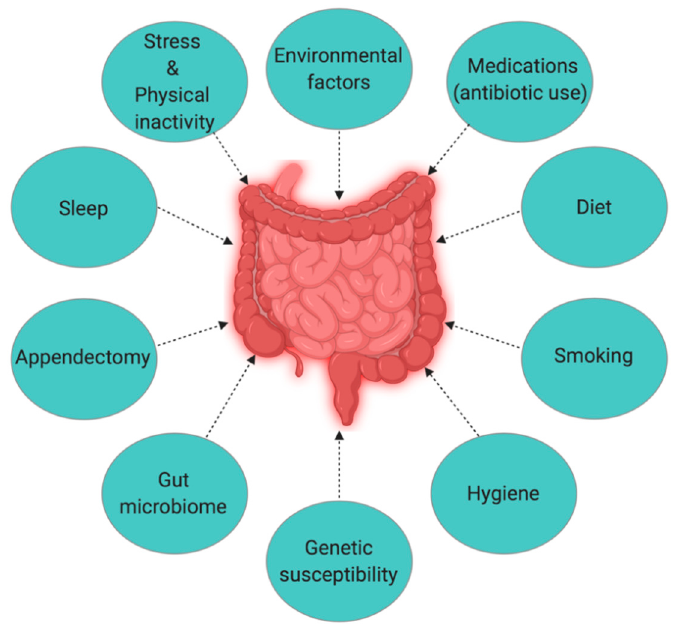
Figure 6. The interplay of factors causing inflammatory bowel disease (IBD).